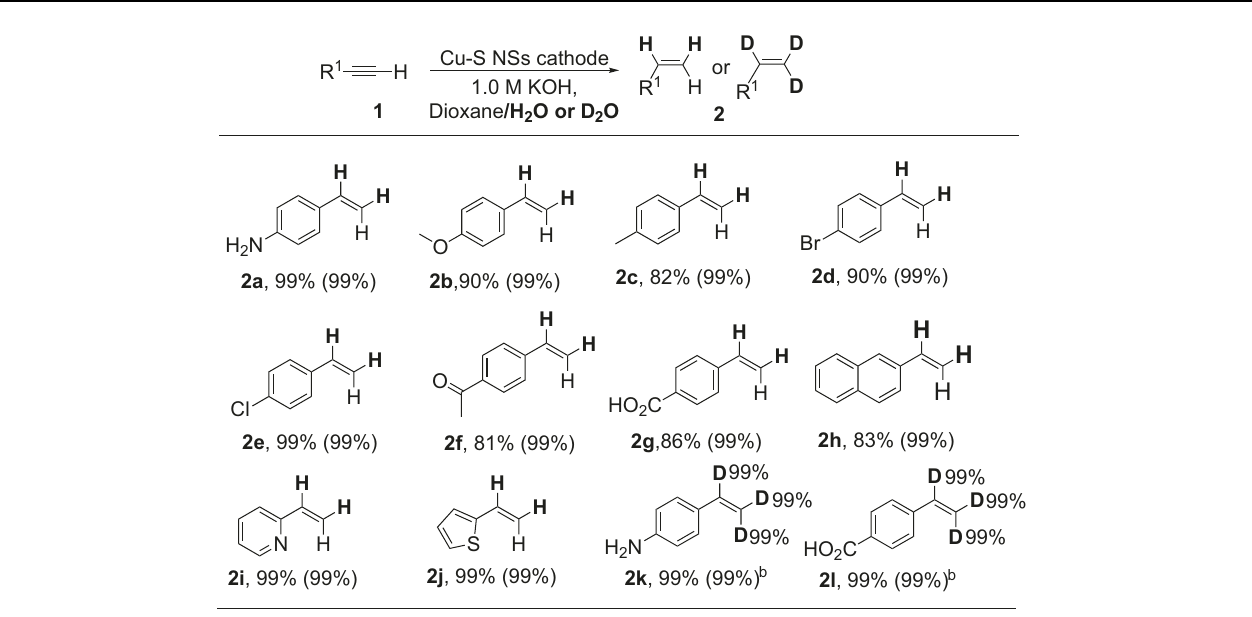
Table 1 Substrate scope for electrocatalytic transfer semi-hydrogenation of alkynes with H 2 O over Cu-S NSs cathode a